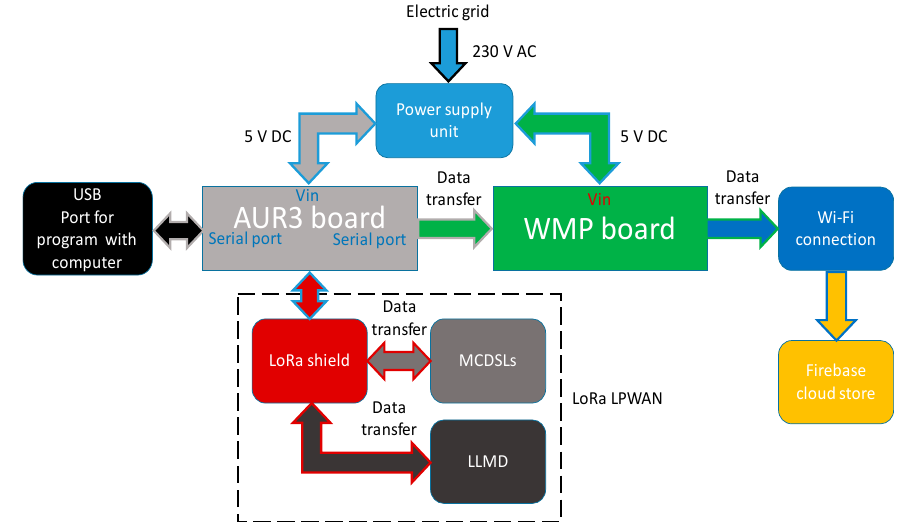
Figure 2. Hardware block diagram of GWLN.